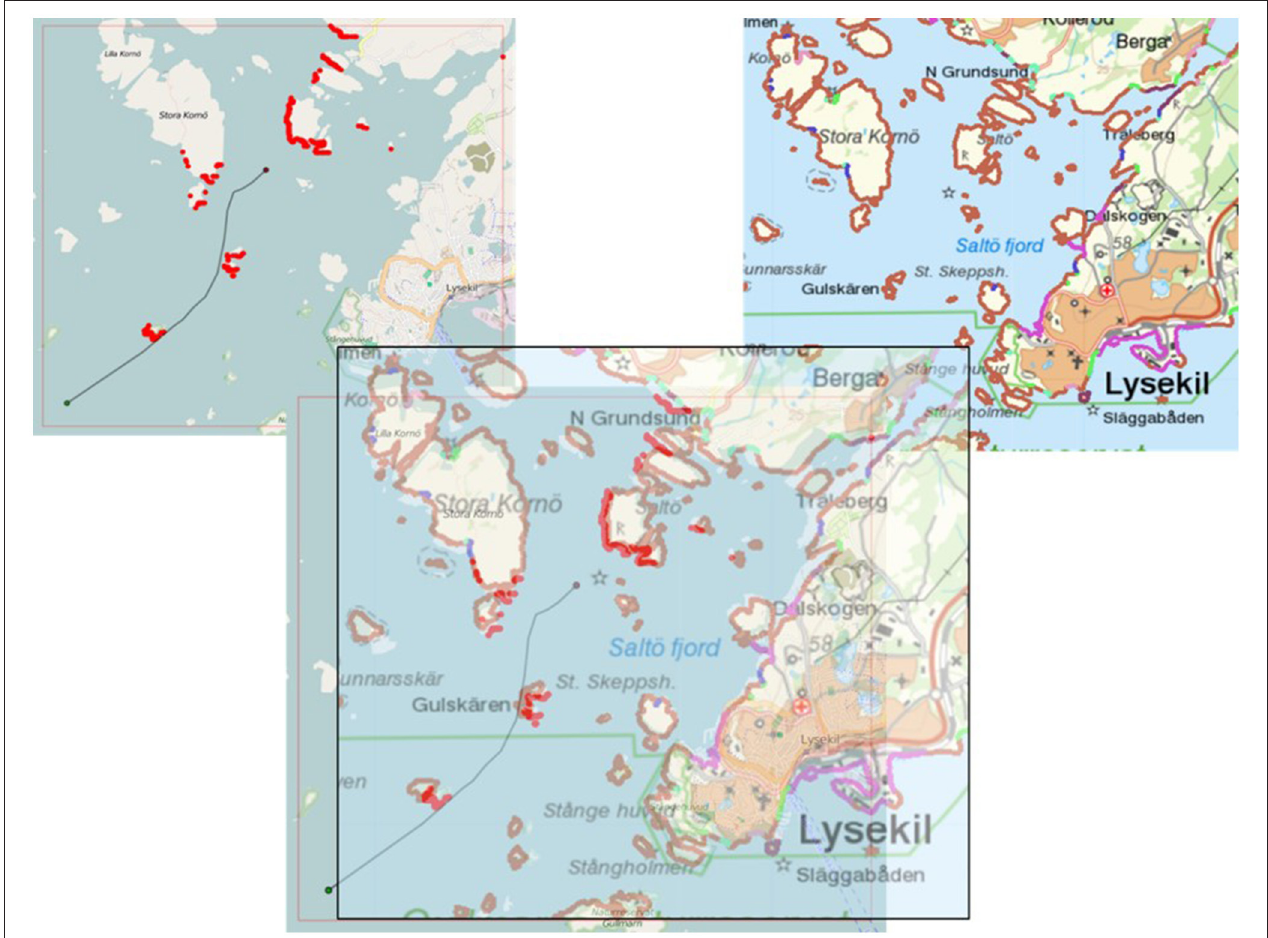
FIGURE 7 | Principal sketch of how data from Seatrack Web and The Digital Environmental Atlas can be combined. Included is an example simulation from Seatrack Web, where the red indicates onshore oil. Examples taken from the Digital Environmental Atlas of shoreline classification in the Lysekil area in Sweden are also presented. Brown, rocky shore; dark purple, rocky shore and steep cliffs; purple, plants; pink, fine sediment beach; turquoise, gravel beach; dark blue, pebble shore; green, sandy